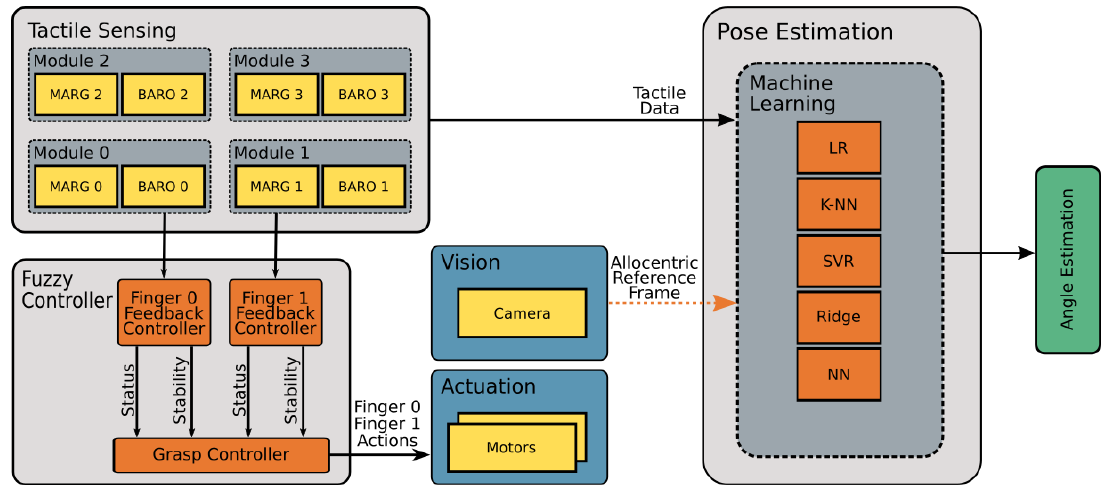
Figure 4. System flow chart.